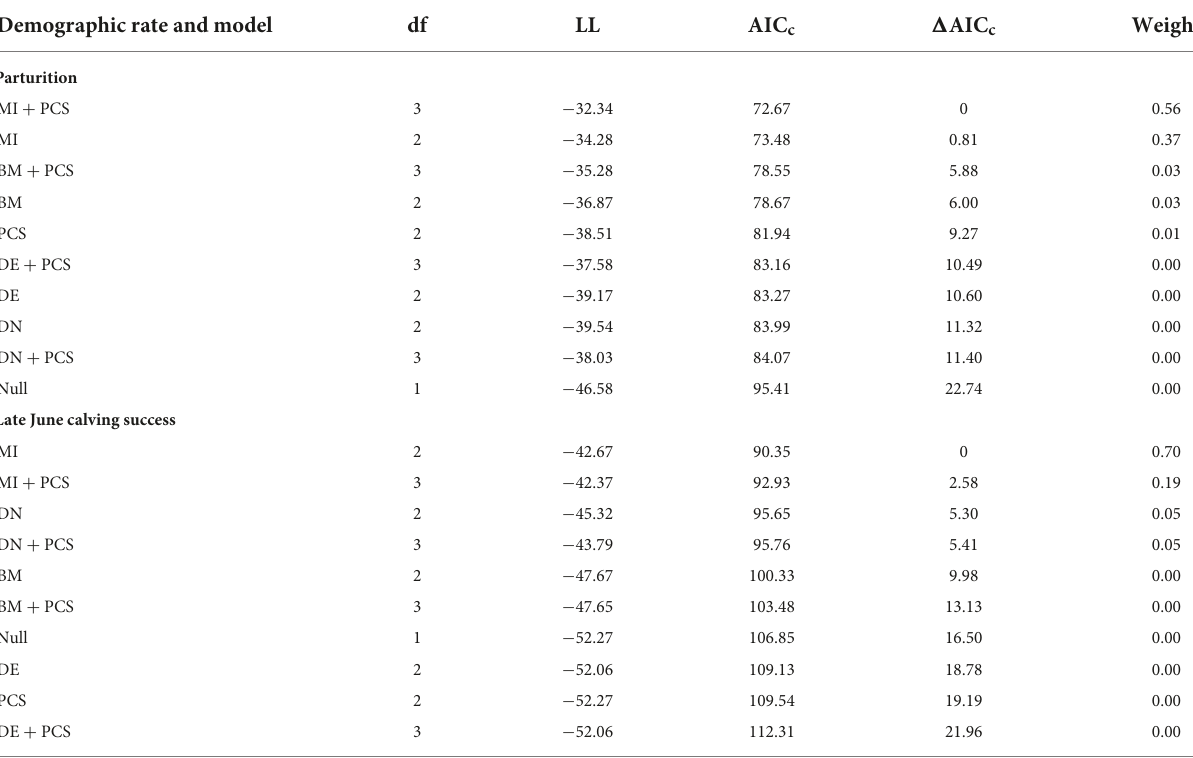
TABLE 4 Model selection criteria for population-level models of parturition and late June calving success of adult female caribou in the Central Arctic Herd, Alaska, 2002–2020. Demographic rate and